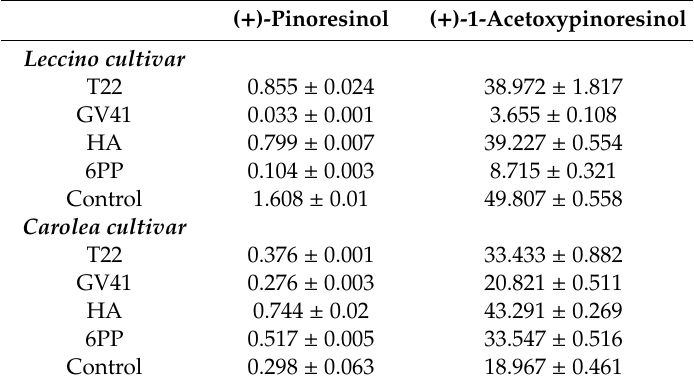
Table 5. Content of lignans in EVOO (mg / kg).